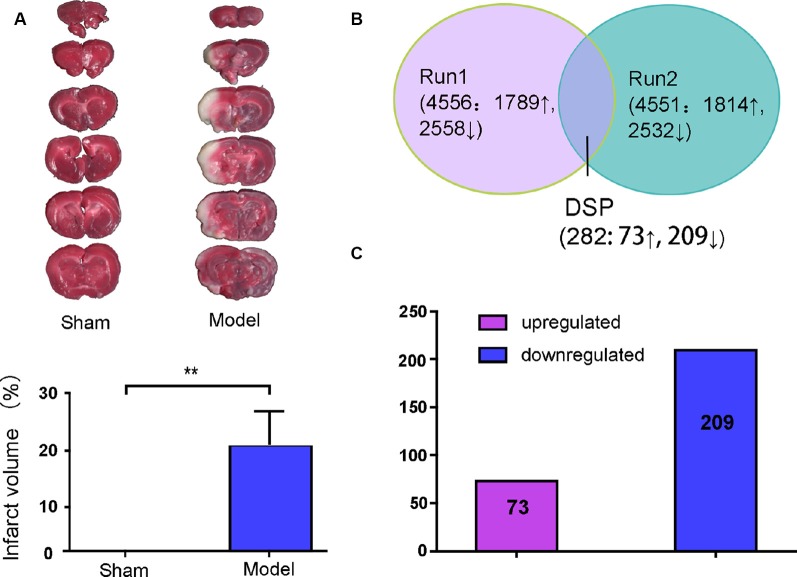
Brain infarction measurement and summary of the identified proteins displayed by Venn diagram and bar chart. (A) Middle cerebral artery occlusion (MCAO) induced a white area, which represents infarction, unlike the sham group. (B) Total proteins and overlap differentially expressed proteins (DEPs) presented in a Venn diagram. Significant changes in the protein ratio were set at 1.2-fold. (C) The average values of 282 DEPs with upregulated (purple) and downregulated (blue) expression between the model group and sham group. Numbers in rectangles respectively show the amounts of altered protein expression. **p < 0.01 compared to the sham group.